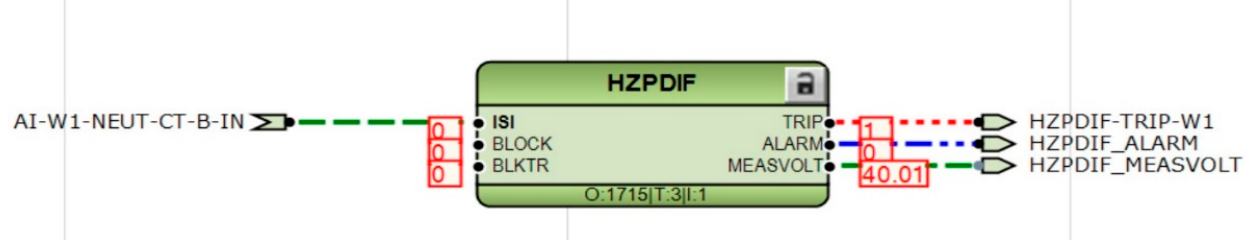
Figure 11. Measured protection operation and voltage by relay logic software ABB-PCM 600 after the sensitivity test.